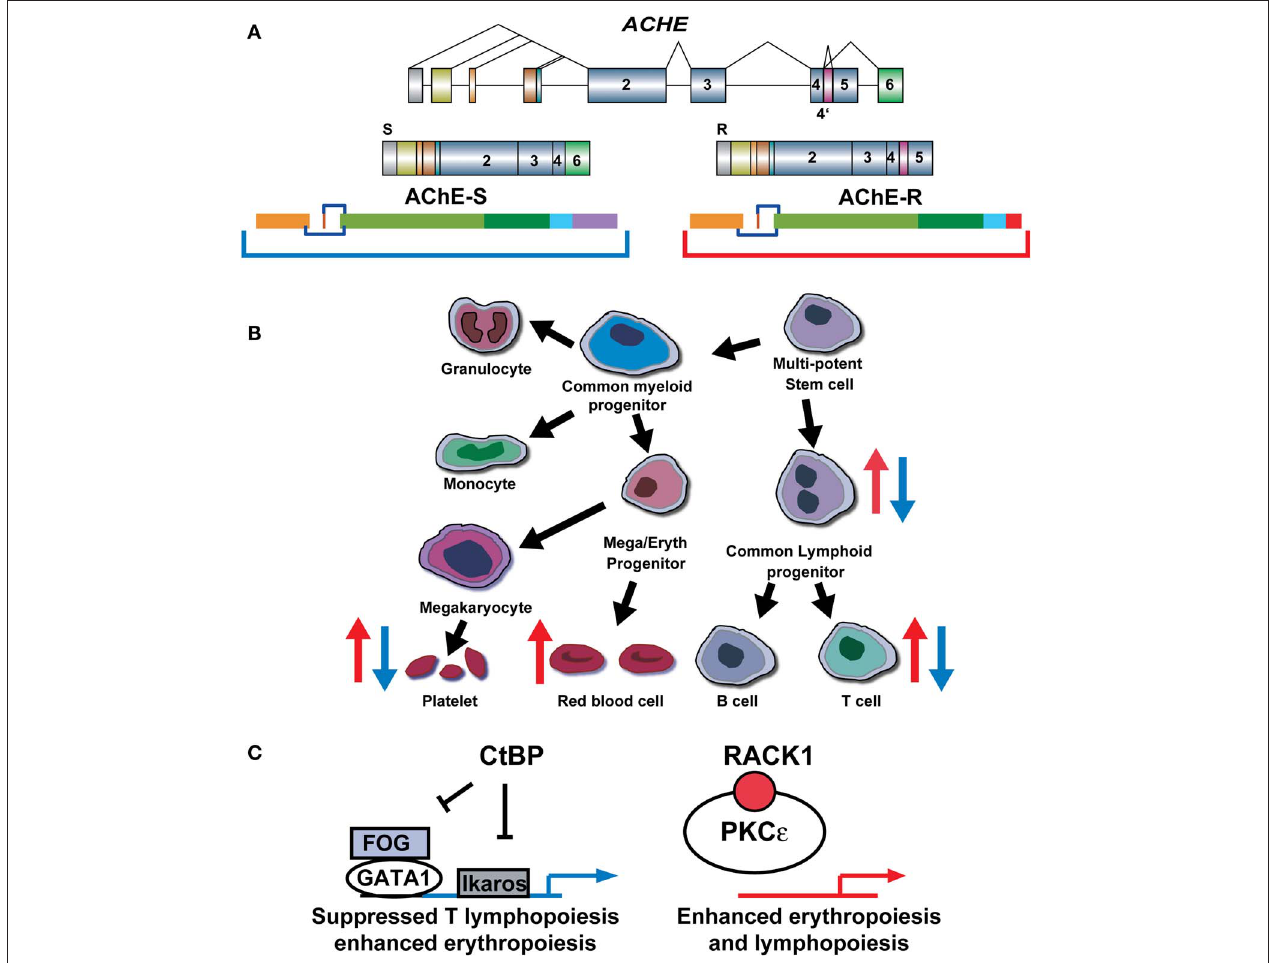
FIGURE 4 | AChE splice variants induce inverse hematopoietic effects. (A) The AChE gene and its S and R transcripts. (B) The hematopietic pathway (black arrows).Up and down changes in cell compositions are presented as